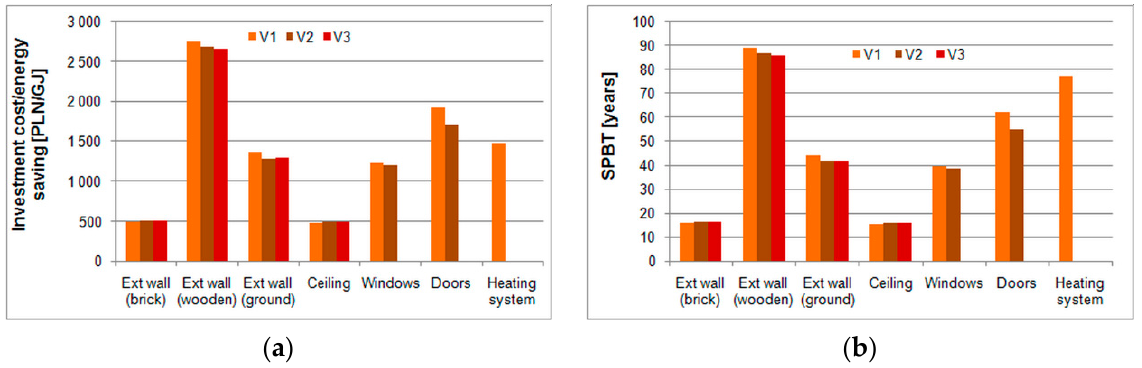
Figure 6. Modernisation variants. ( a ) Investment cost per energy saving. ( b ) Simple payback time (SPBT).